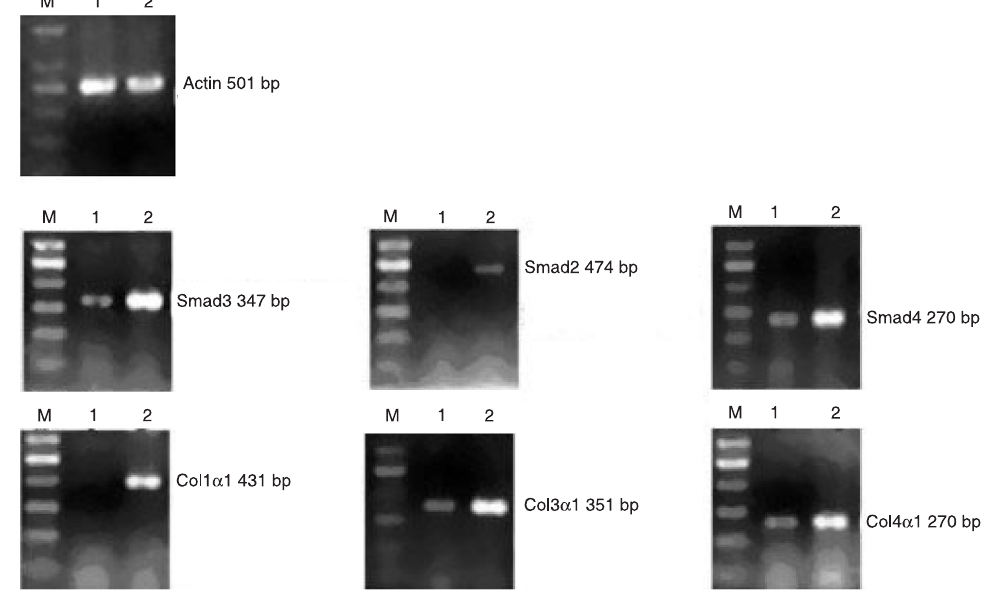
Figure 5. RT-PCR profiles of Smad2, 3, and 4, and Col1α1, Col3α1, Col4α1 mRNAs in hepatic stellate cells (HSCs) transfected with the effective Smad3 siRNA expression vector. M , Marker; Lane 1 : HSCs transfected with the SD1211-SiSmad3-2 vector; lane 2 : normal HSCs.